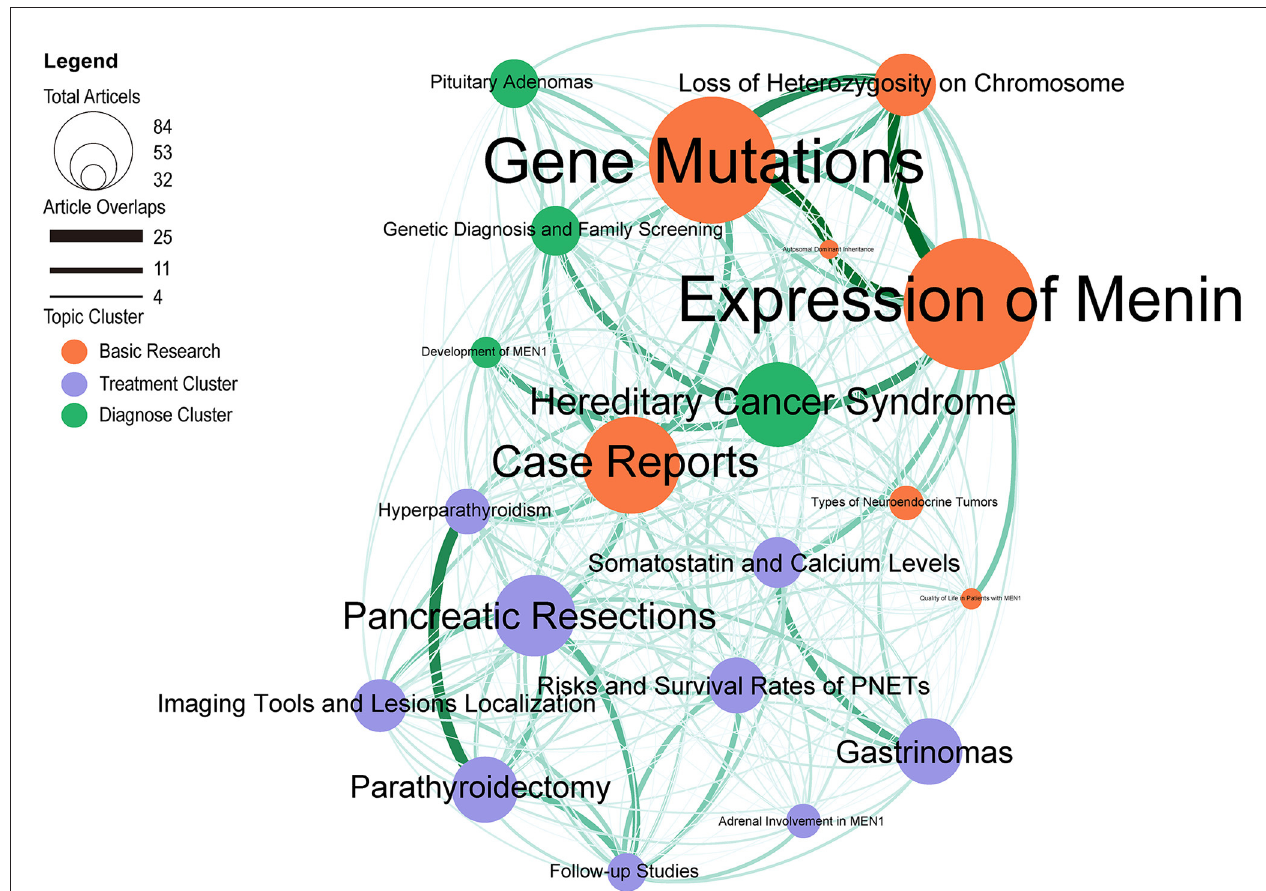
FIGURE 6 | LDA research topic cluster network: inter-and